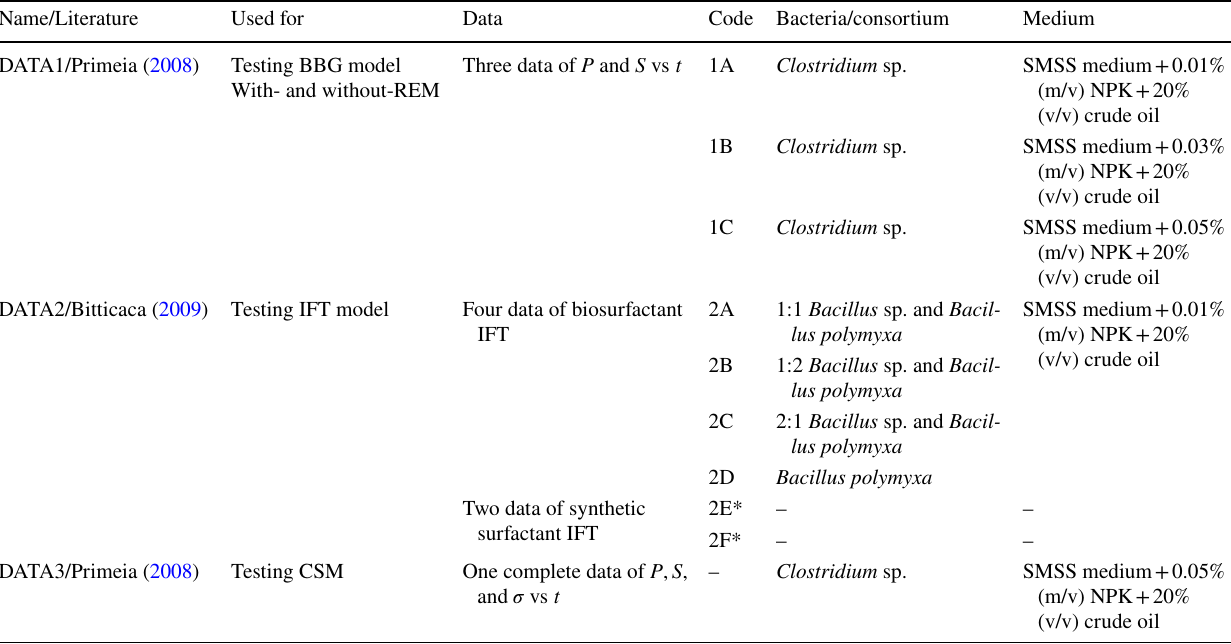
Table 3 List of the experimental data